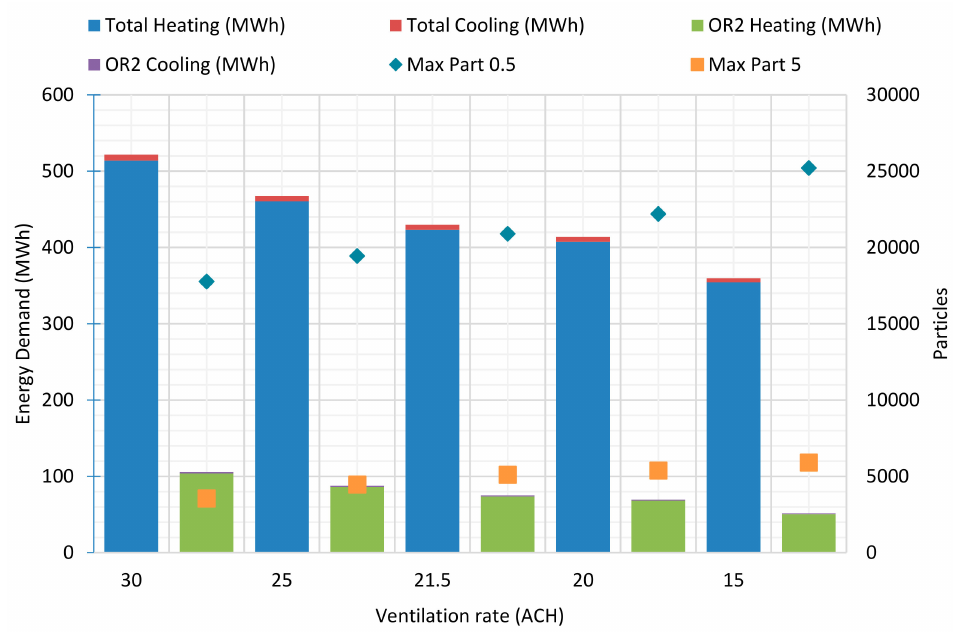
Figure 10. Energy demand and particles simulated in the five di ff erent